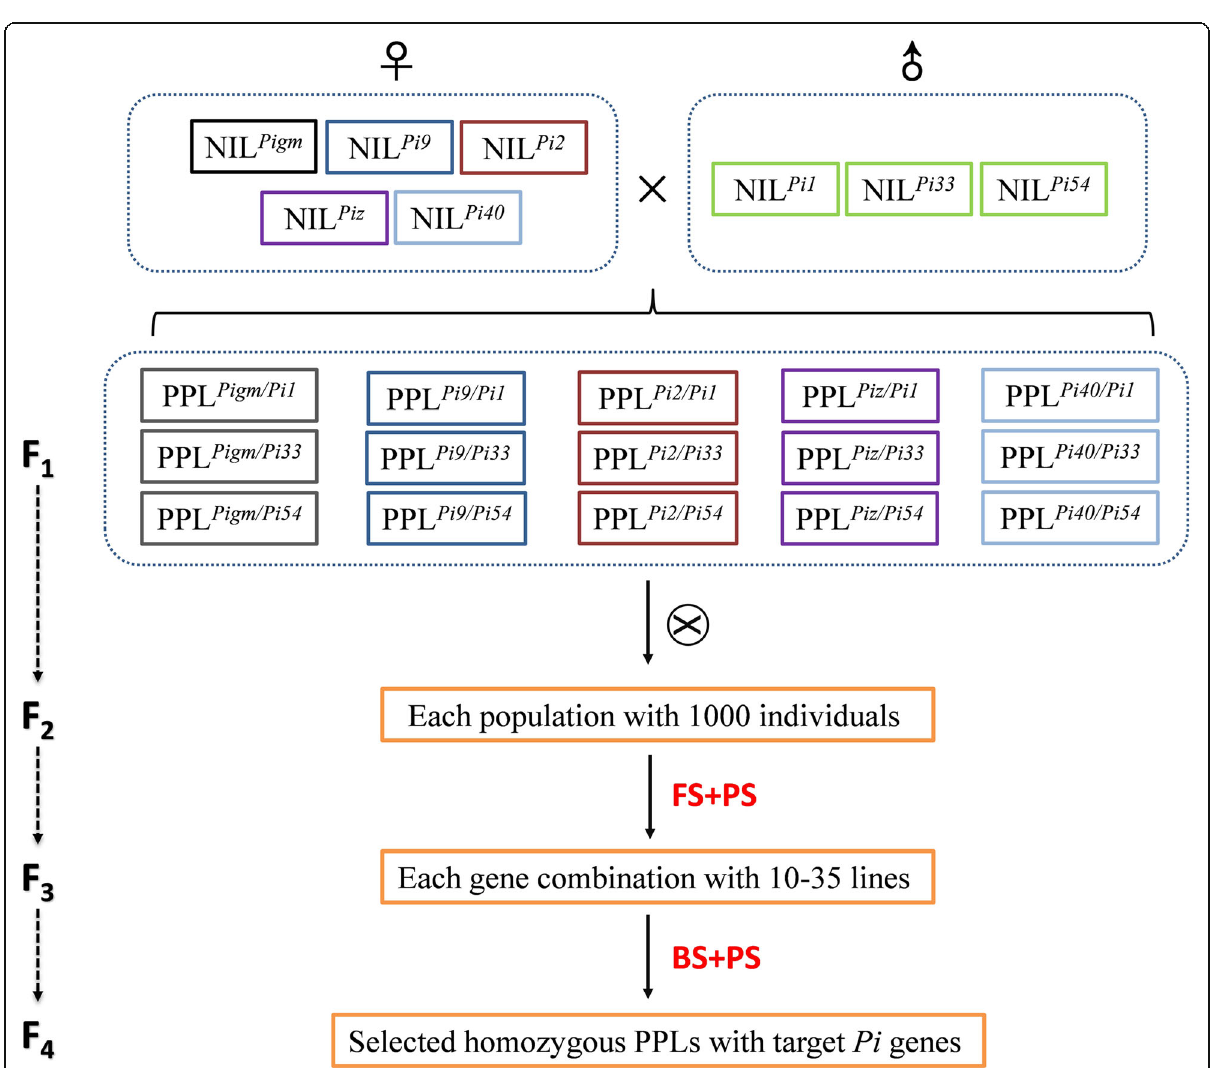
Fig. 1 Breeding scheme for generation of PPLs. FS, foreground selection of Pi genes; BS, background selection by GBS analysis; PS, phenotype selection for yield and morphology related